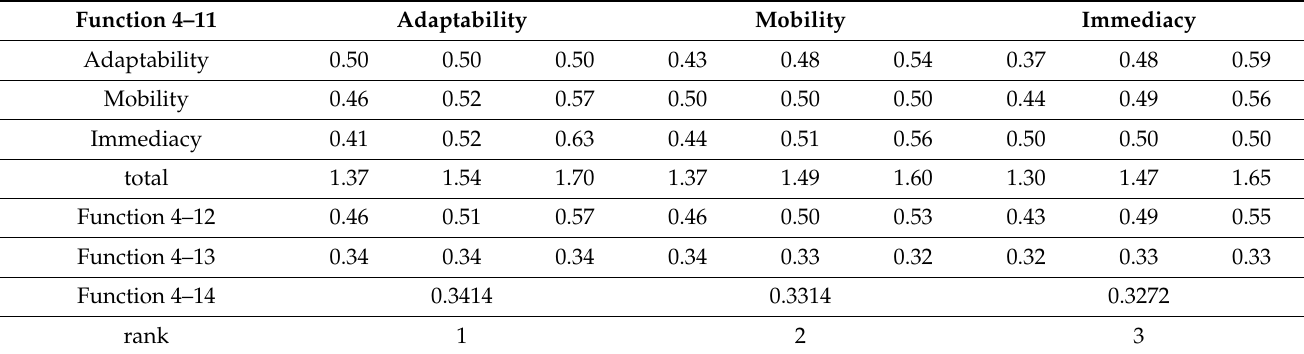
Table A17. Hotels’ weights of attributes of the conditional value.